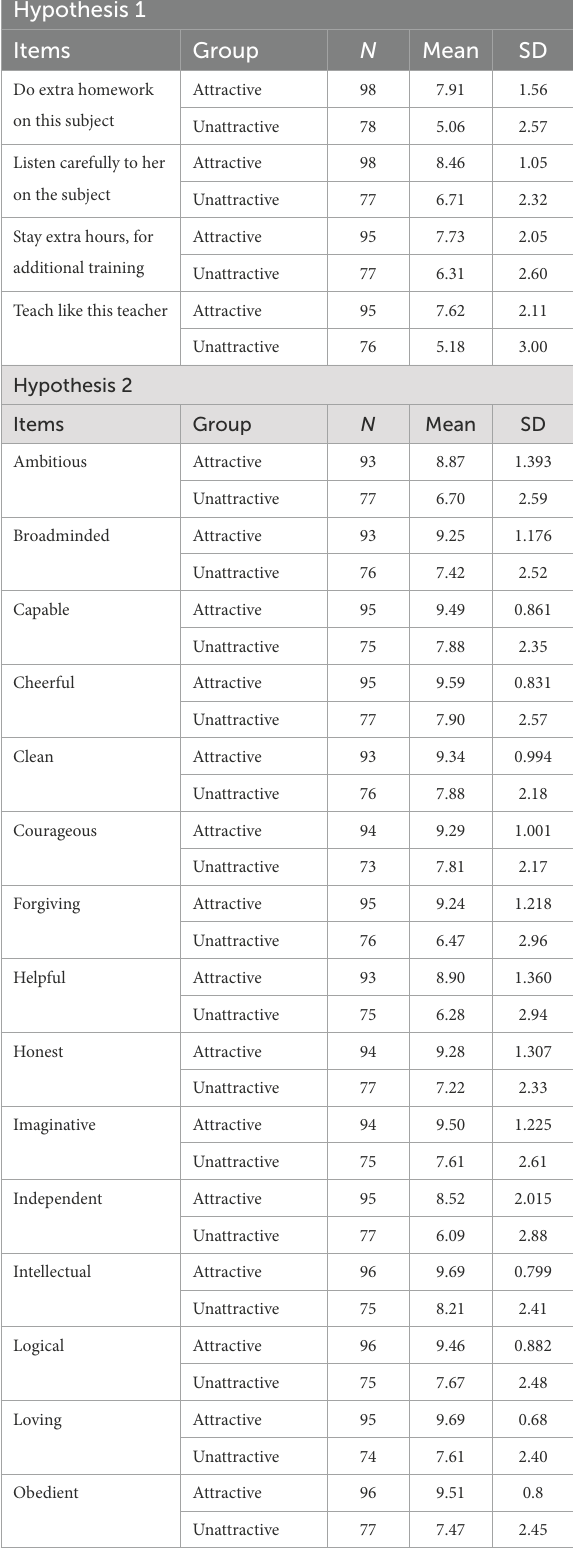
TABLE 2 Descriptive statistics based on the hypotheses tested: Items, Independent Variable Levels (Group), Number of Subjects ( N ), Mean, and Standard Deviation